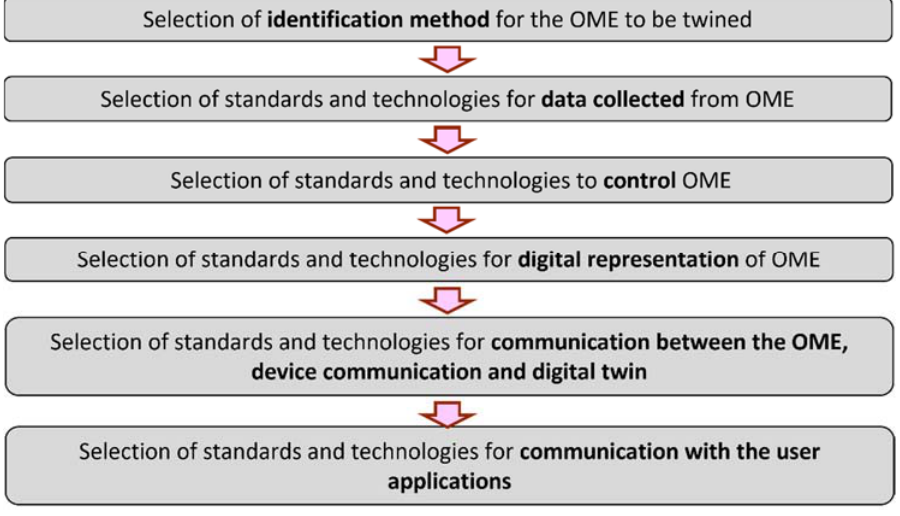
Figure 3. Steps to use standards and technologies to create a digital twin based on ISO 23247.